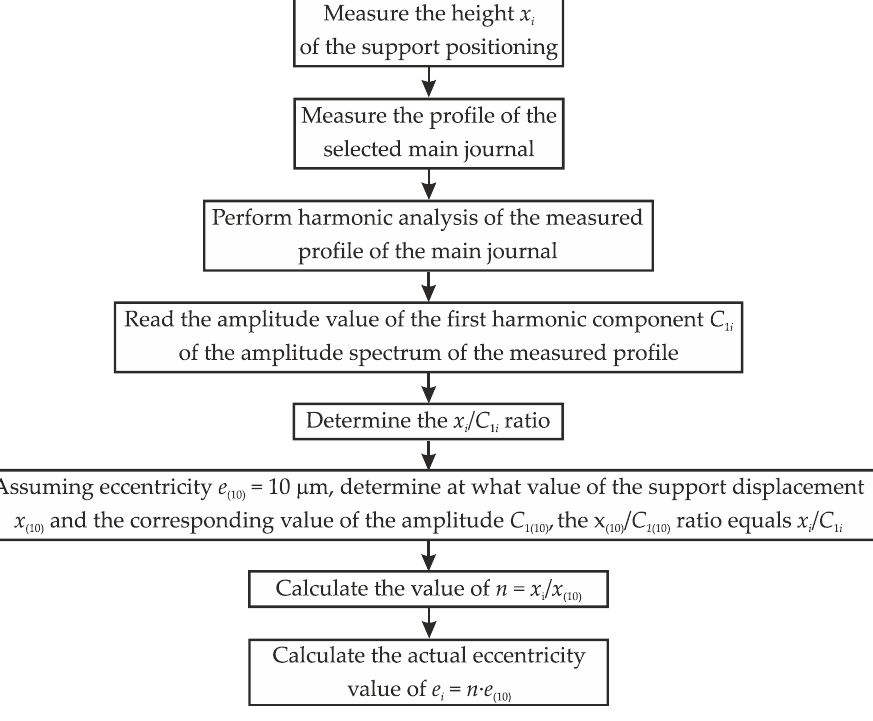
Figure 8. Algorithm for determining the actual eccentricity value e i from the known parameters x i and C 1 i .